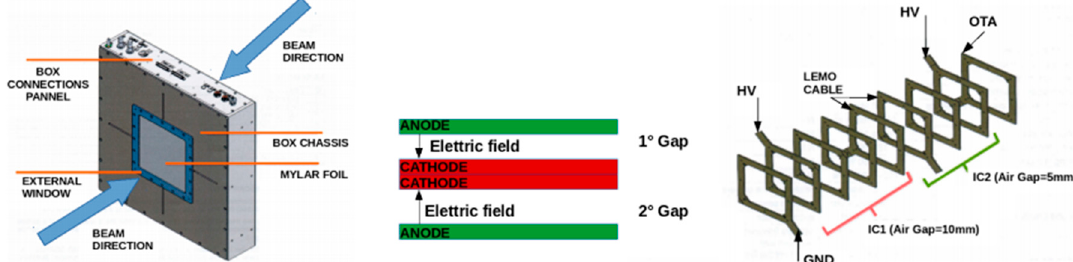
Figure 9. An overview of multi-gap ionization chamber (MGIC), the scheme of electrode and the sensors package composed of frames used in stack, in order to separate the cathodes and the anodes and to support the MGIC at the center of the box. In the sensors package (on the right), IC1 is indicated by the red bracket and IC2 by the green bracket.